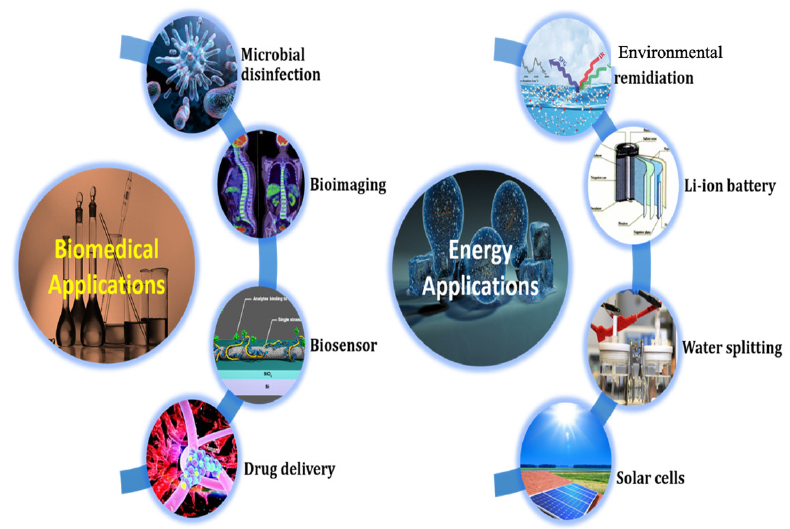
Figure 1. Applications of multifunctional nanocomposites.